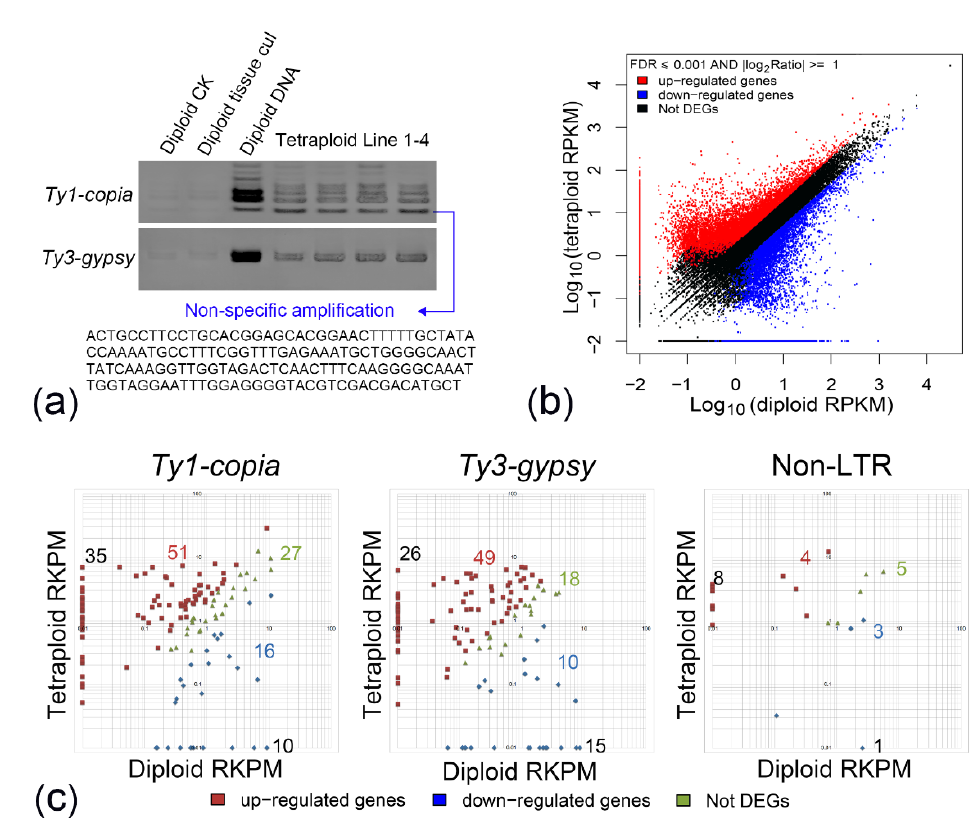
Figure 4. Transcriptional activation of LTR retrotransposons following autopolyploidization. ( a ) Polyacrylamide gel electrophoresis of the Ty1RT and Ty3RT sequences of diploid (tissue-cultured and non-tissue-cultured) and tetraploid species of C. nankingense . The Ty1RT bands at the bottom of the gel show non-specific amplification. ( b ) Analysis of the differentially expressed genes of diploid and tetraploid species of C. nankingense . ( c ) Analysis of the Ty1- copia , Ty3- gypsy , and non-LTR-type retrotransposons of diploid and tetraploid species of C. nankingense .